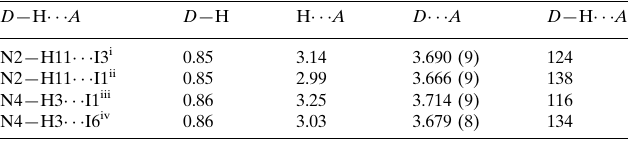
Hydrogen-bond geometry (A˚ , (cid:3)